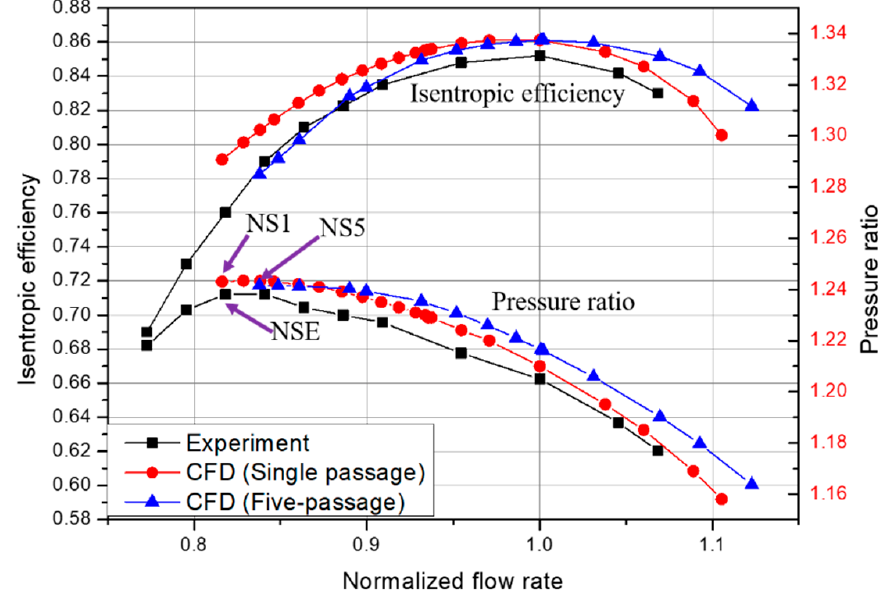
Figure 4. Overall performances of prototype stages.